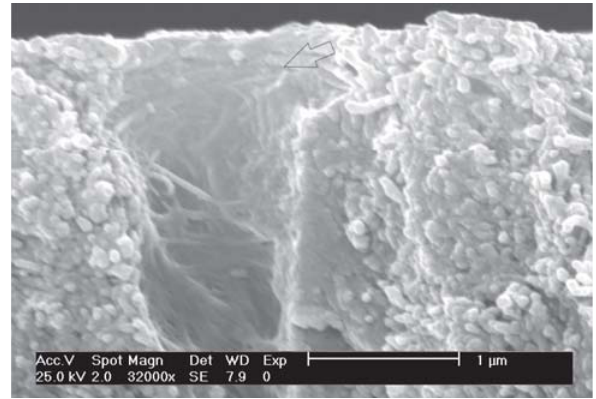
FIGURE 4- SEM micrograph of group 2 (37% phosphoric acid etching) - Occlusal view of one dentinal tubule. Observe the dentin surface free of smear layer and ope tubule (x8,000)